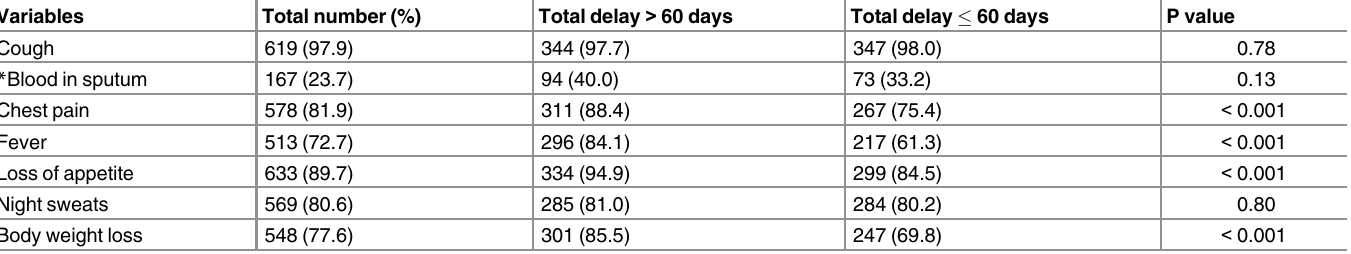
Table 3. Baseline signs and symptoms of new PTB patients stratified by median total delay, October 2013 to May 2015, West Gojjam Zone,